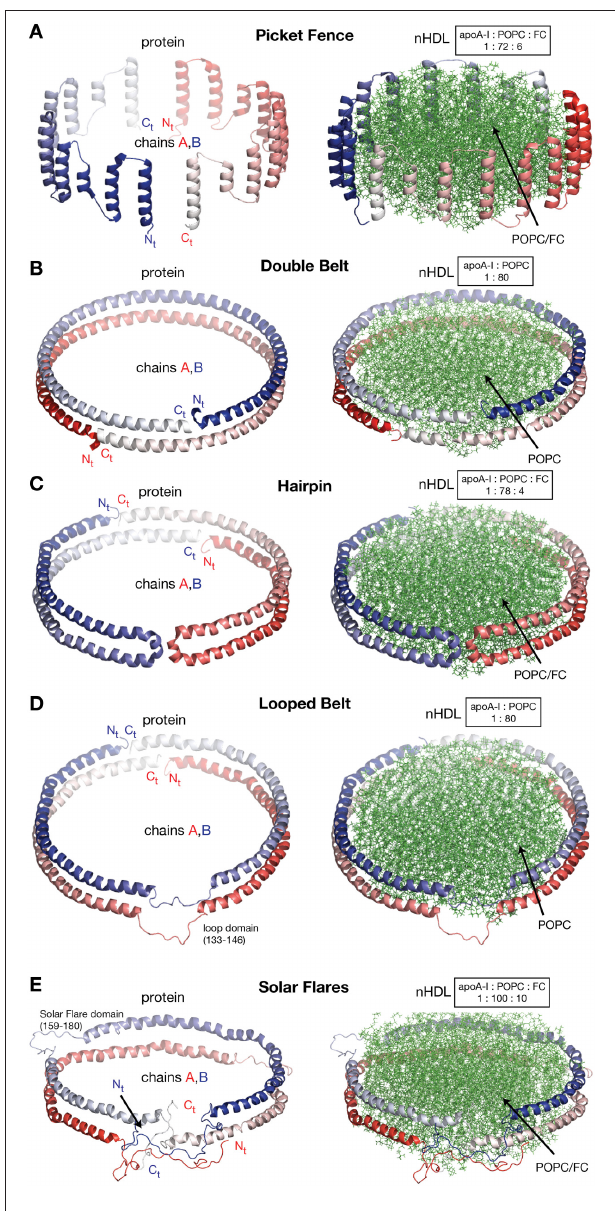
FIGURE 4 | Discoidal models of nHDL. In all models the apoA-I chains are shown in cartoon representation and colored with gradient red/blue (N t solid = color and C t faded color). (A) Left: the picket fence model of the apoA-I = dimer ( 1 43–apoA-I; Jonas et al., 1989; Wald et al., 1990a,b; Nolte and Atkinson, 1992; Phillips et al., 1997); the amphipathic apoA-I α -helices are oriented parallel with the PL molecules. Right: the picket fence model of nHDL (Phillips et al., 1997). The lipid bilayer is made of 144 POPC and 12 FC molecules. (B) Left: computational model of the apoA-I dimer ( 1 43–apoA-I) used in the Double Belt model of nHDL proposed by Segrest et al. (1999); the apoA-I chains are oriented antiparallel and stacked on top of each other in helix 5 registry. Right: the Double Belt model of nHDL proposed by Segrest et al. (1999) . The lipid bilayer is made of 160 POPC molecules. (C) Left: model of the apoA-I dimer ( 1 43–apoA-I) used in the Hairpin model of nHDL proposed by Silva et al. (2005b); apoA-I monomers form semicircular hairpins located at the periphery of the lipid bilayer, which interact through a couple of residues from repeat 5 and the end domain of C t (V 221 –Q 243 ). Right: the